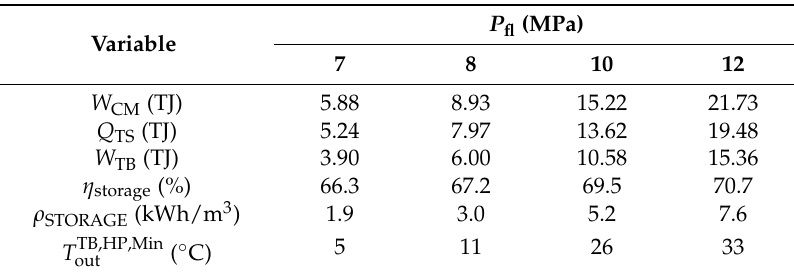
Table 6. Sensitivity of the A-CAES model to the maximum storage